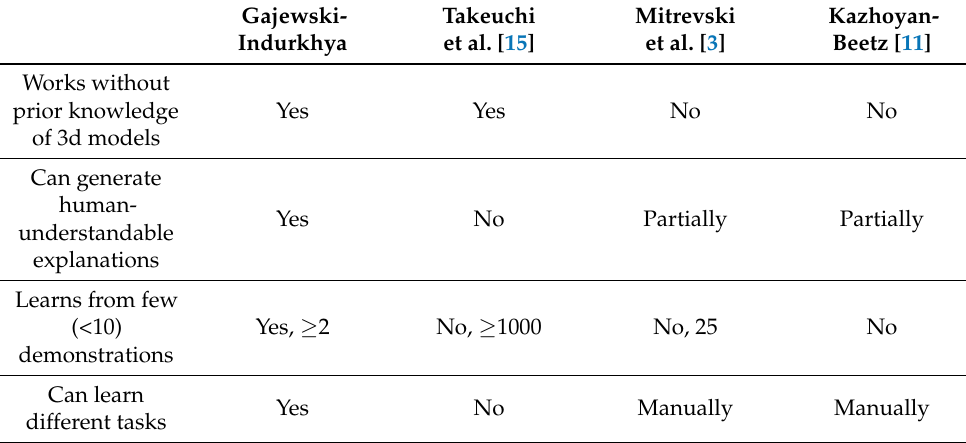
Table 1. A comparison of some aspects of related works that can be compared with our system. Takeuchi et al. is a deep learning-based approach while Mitrevski et al. and Kazhoyan and Beetz are based on symbolic knowledge, they require some programming in order to be used in different tasks. The Kazhoyan and Beetz system offers a programmable interface instead of